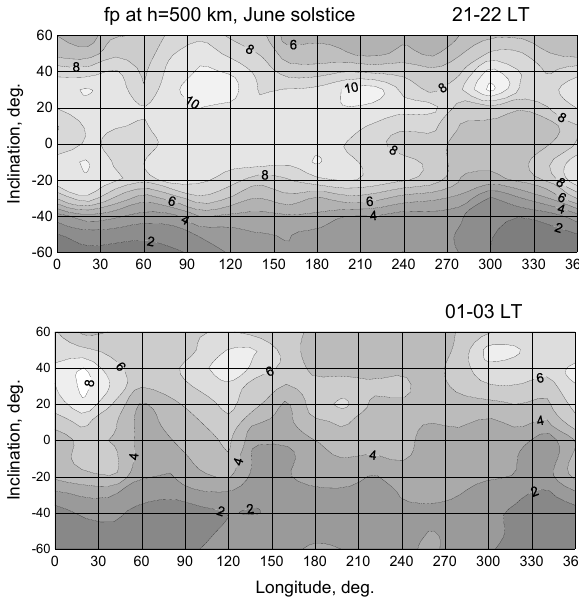
Fig. 7. The same as in Fig. 6 but for fp at a height of